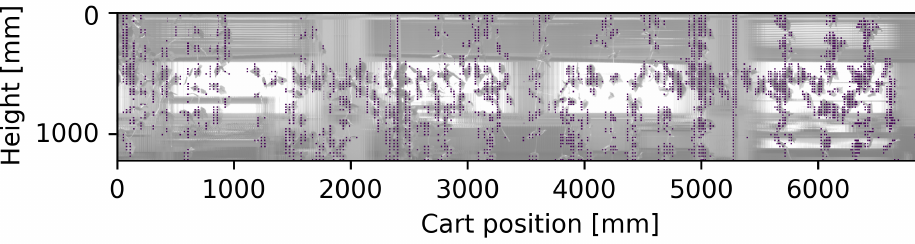
Figure 7. Estimated profile of vineyard with LIDAR superimposed on the panoramic image of the test